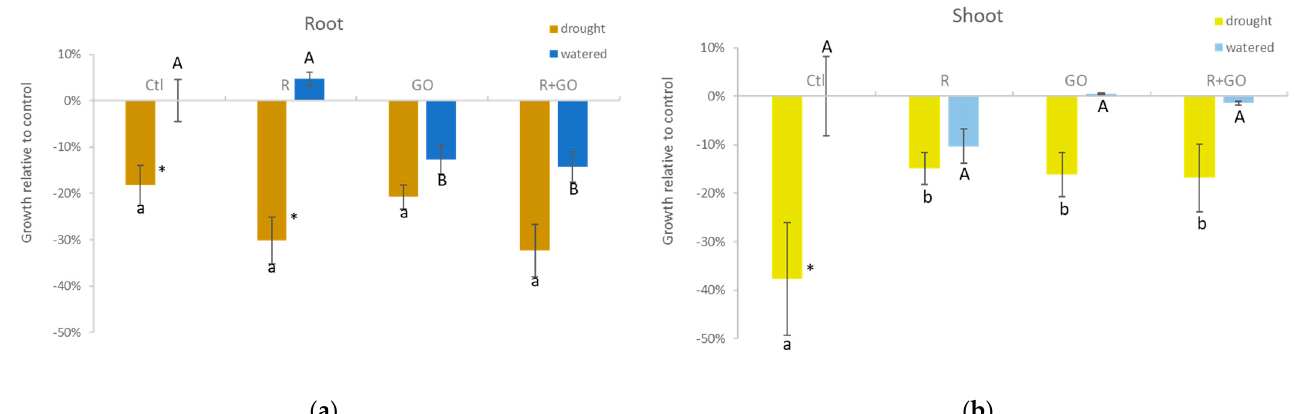
Figure 2 . Root ( a ) and shoot ( b ) growth relative to control (condition Ctl) of maize plants watered (blue bars) or drought (brown bars) grown at different conditions. Ctl—no addition of graphene oxide nanosheets, no bacterial inoculation; R—no graphene oxide nanosheets addition, inoculation with Rhizobium strain E20-8; GO—addition of graphene oxide nanosheets, no bacterial inoculation; R + GO—addition of graphene oxide nanosheets and inoculation with Rhizobium strain E20-8. Values are means of at least six replicates ± standard error. Different uppercase letters indicate significant differences ( p < 0.05) among conditions in watered plants, different lowercase letters indicate significant differences among conditions in drought plants, and asterisks indicate significant differences between drought and watered plants for the same condition.